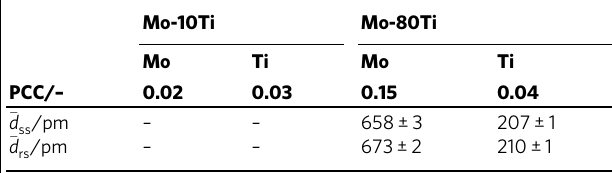
Table 1 Pearson correlation coef fi cients (PCC) for the element distribution in both alloys investigated in APT.